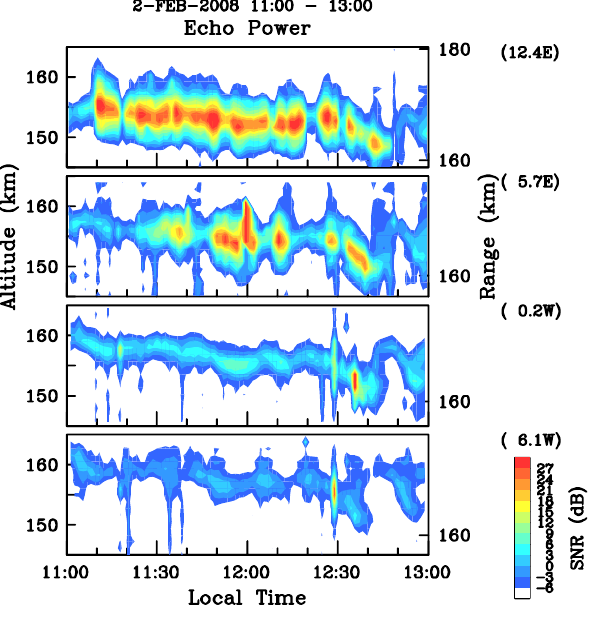
Fig. 3. Same as Fig. 2a except the 150-km region is expanded.